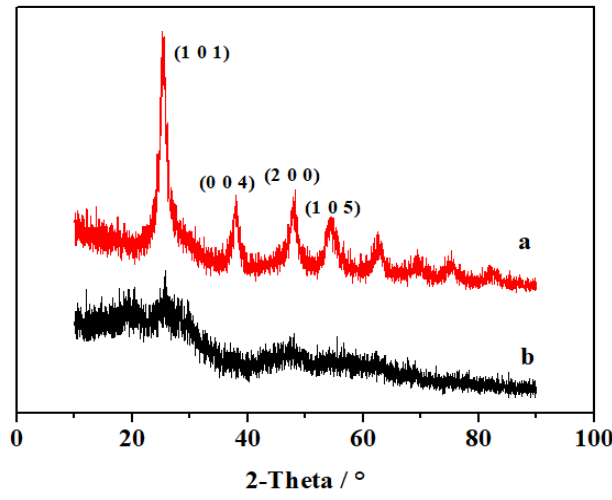
Figure 1. X-ray diffraction (XRD) spectra of TiO 2 -modified sol coating material (TSCM) ( a ) and p-sol ( b ).